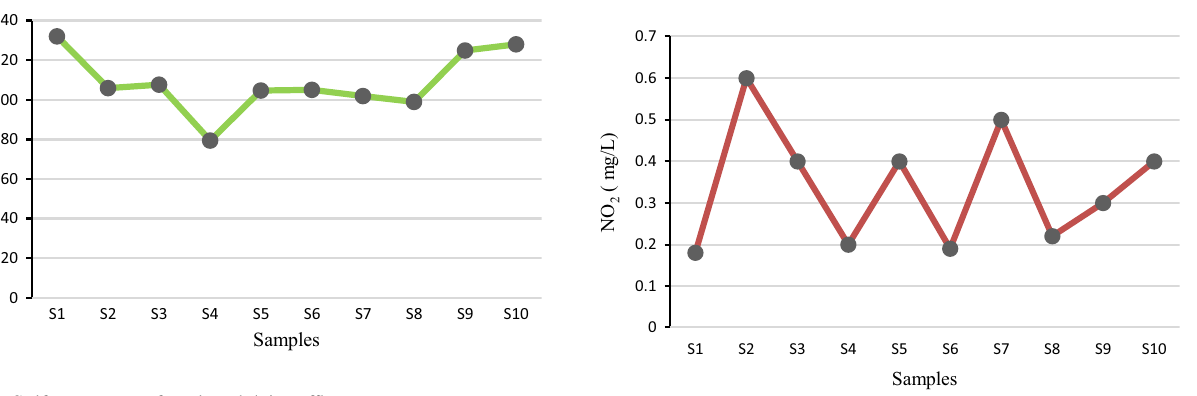
Fig. 7 Sulfate content of analyzed dairy effluents